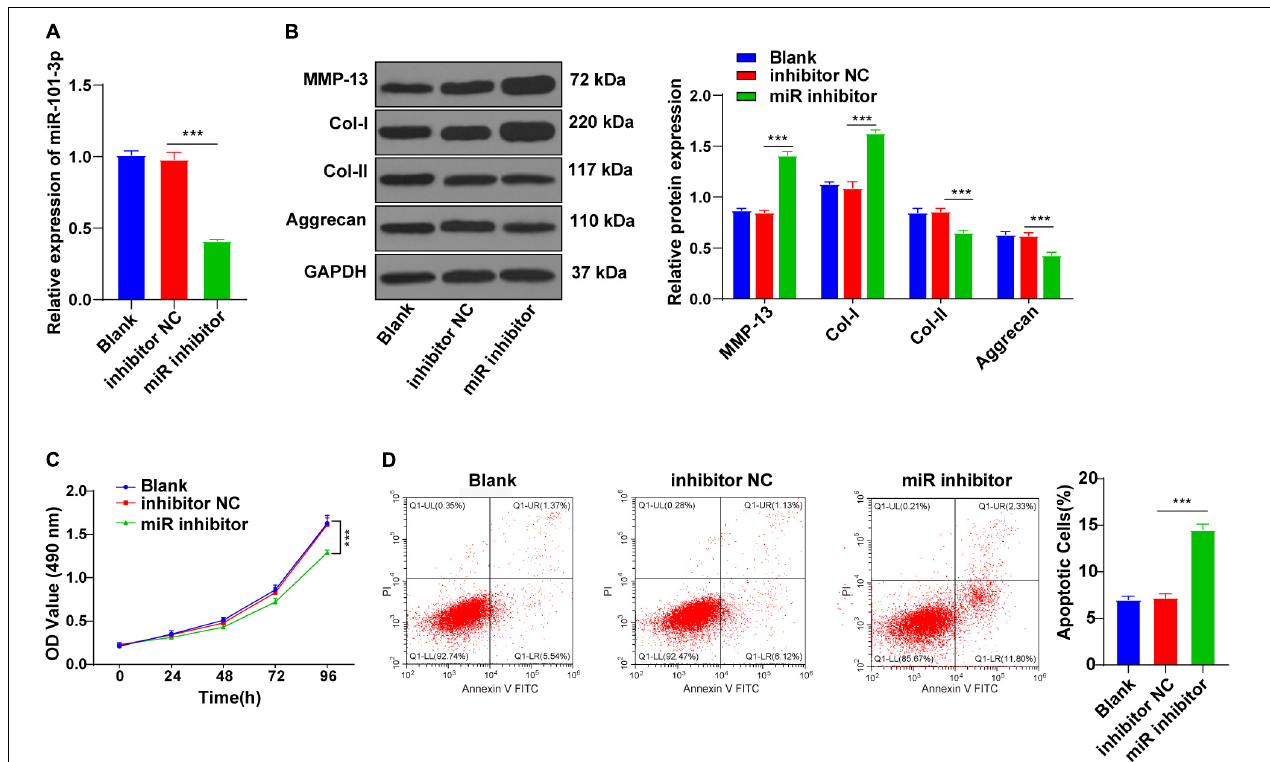
FIGURE 3 | Downregulation of miR-101-3p inhibited the effect of BMSCs on ECM remodeling of NPCs. NPCs of patients with IDD were cocultured with BMSCs and then transfected with miR-101-3p inhibitor, with transfection of inhibitor negative control as control. (A) miR-101-3p expressions were detected using the RT-qPCR; (B) MMP-13, Col-I, Col-II, and Aggrecan levels were detected using Western blotting; and (C,D) viability and apoptosis of NPCs were detected using MTT assay and flow cytometry. The cell experiments were repeated three times independently. Data are presented as mean ± SD. Data were analyzed using one-way ANOVA, followed by the Tukey’s multiple comparison test, *** p <